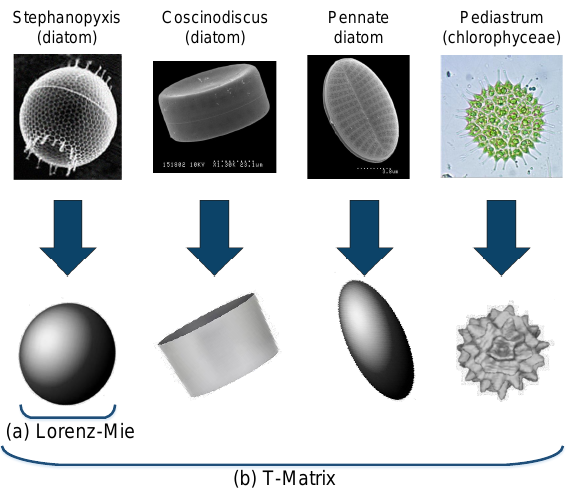
Figure 1. (a) The Lorenz–Mie method only describes the scattering of an electromagnetic plane wave by a homogeneous sphere, while (b) the T -Matrix method also characterizes the scattering by non- spherical particles such as spheroids, cylinders, or Chebyshev par- ticles. Both can be used on actual phytoplankton particles by using a suitable